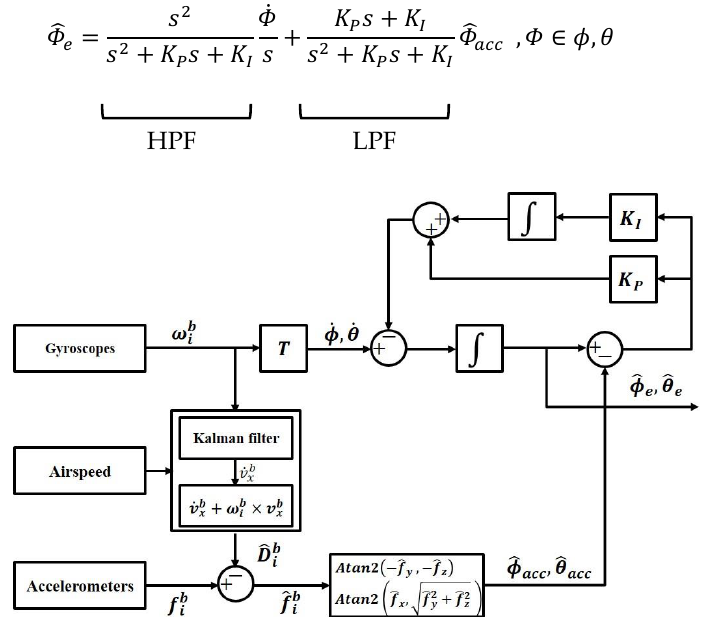
Figure 1. Airspeed-aided complementary filter.